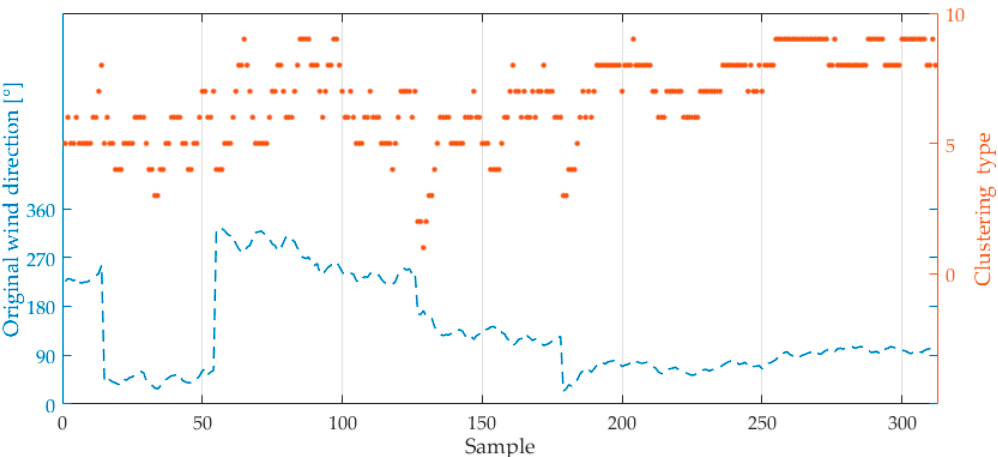
Figure 3. The wind direction processing data of "Dong-Chao line".